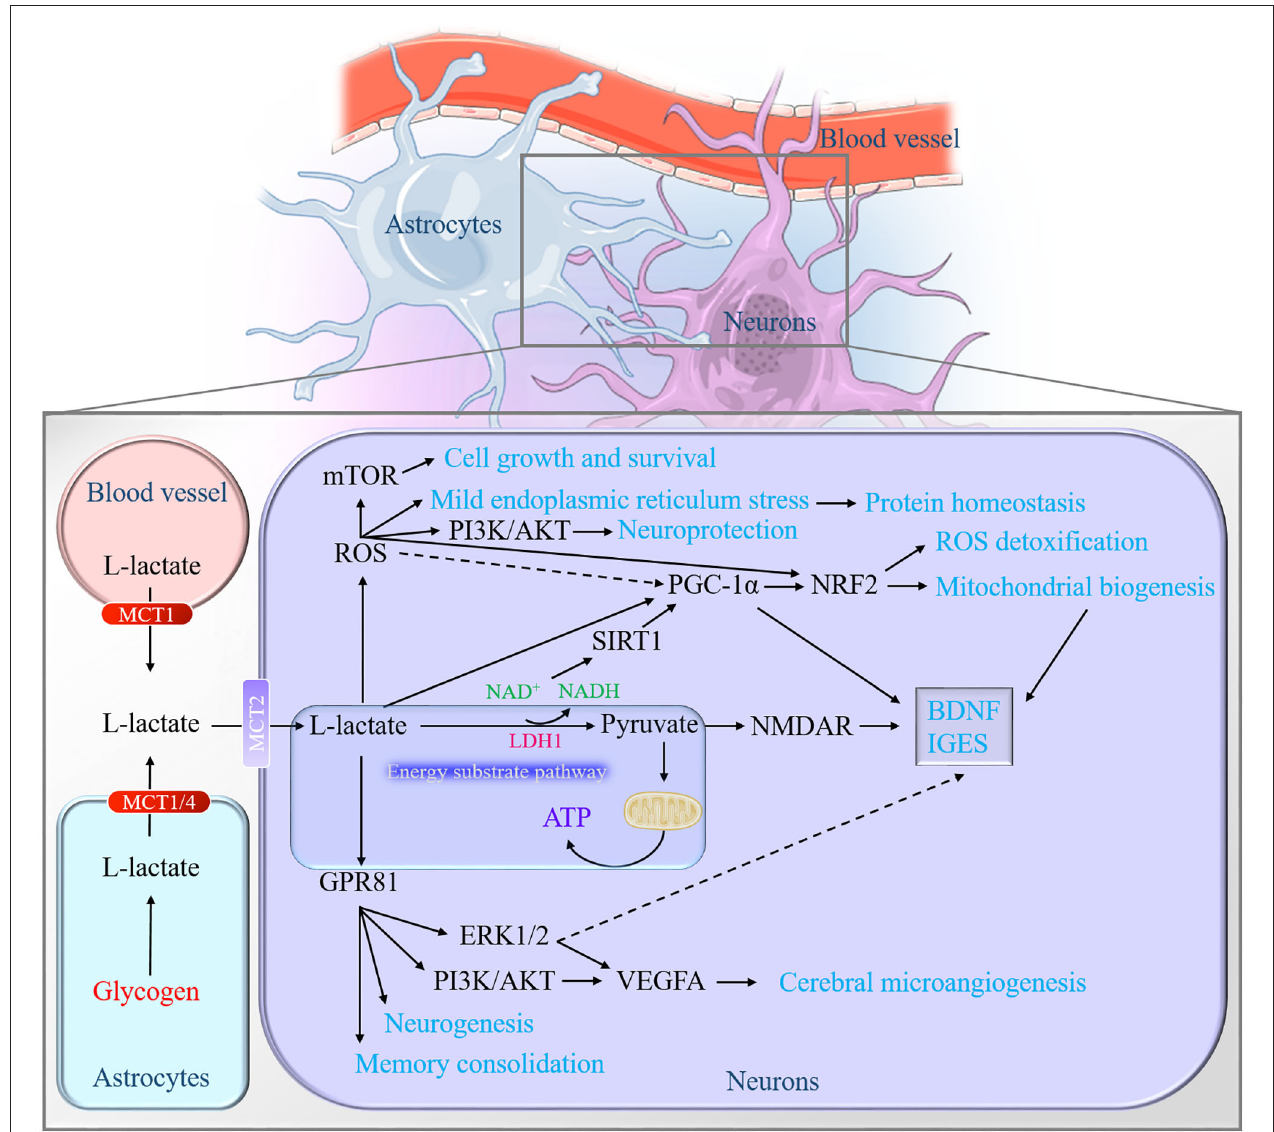
FIGURE 3 | Graphical summary of the neurobiological role of L-lactate in the brain. On the one hand, L-lactate serves as an energy pool for neurons to facilitate mitochondrial energy production through converting into pyruvate. On the other hand, L-lactate may act as the role like the hormone, defined as lactormone. It triggers multiple downstream signaling cascades via influencing the intracellular NADH/NAD + ratio, mediating the ROS generation, and activating the receptor GPR81. NADH, nicotinamide adenine dinucleotide; ROS, reactive oxygen species; GPR81, G i -protein-coupled receptor